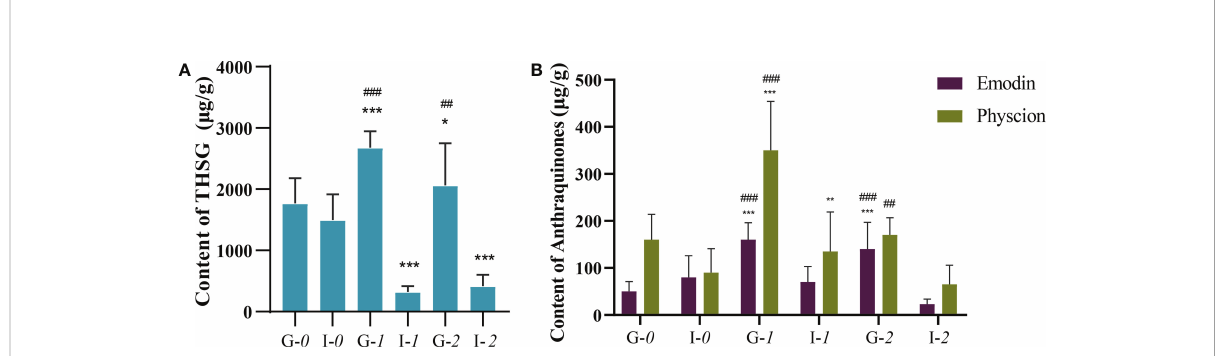
FIGURE 6 Determination of THSG and AQs contents in hairy roots. (A) The contents of THSG in each group. (B) The contents of AQs in each group. G- 0 : pK7WG2D- 0 ; i- 0 : pK7GWIWG2D- 0 ; G- 1 : pK7WG2D- FmUGT1 ; i- 1 : pK7GWIWG2D- FmUGT1i ; G- 2 : pK7WG2D- FmUGT2 ; i- 2 : pK7GWIWG2D- FmUGT2i . * Indicates a signi fi cant difference between the control groups and OE/RNAi groups at P < 0.05, ** Indicates a signi fi cant difference between the control groups and OE/RNAi groups at P < 0.01, and *** indicates a signi fi cant difference at P <0.001. ### Indicates a signi fi cant difference at P < 0.001 between the OE groups and RNAi groups. Every group contained three biological replicates with three technical replicates each. The vertical bar represents mean ± SD (n =